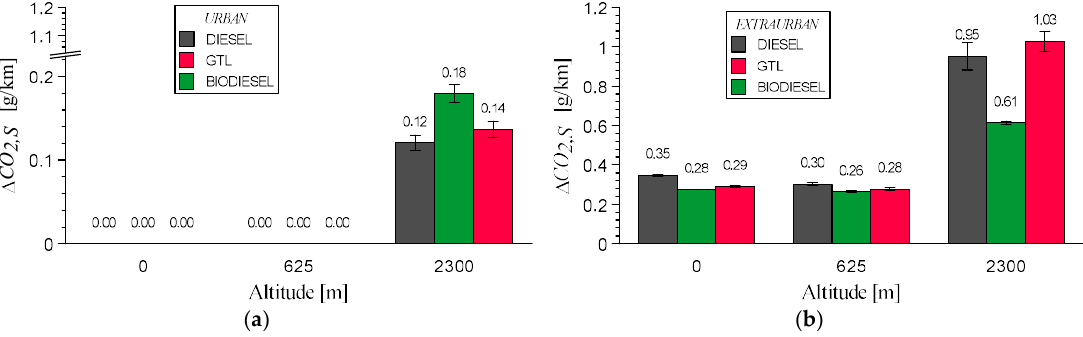
Figure 10. Estimated carbon dioxide emissions savings: ( a ) Urban driving conditions, ( b ) Extra-urban driving conditions.